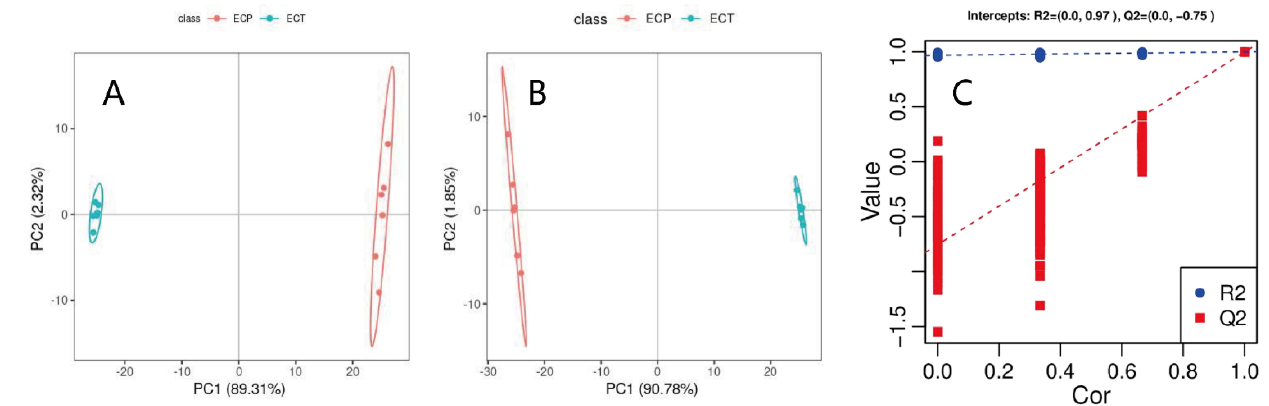
Figure 2. ( A ) PCA score chart of ECT and ECP; ( B ) PLS−DA score chart of ECT and ECP; and ( C ) ( C ) response sequencing test diagram of PLS − DA analysis response sequencing test diagram of PLS−DA analysis model.